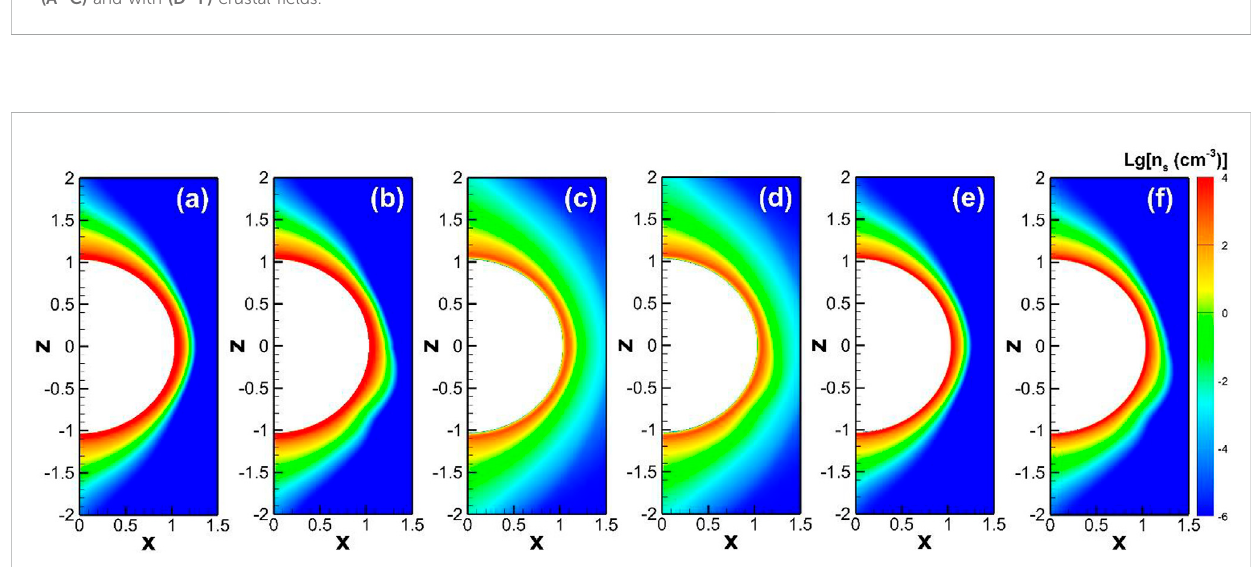
FIGURE 5 The dayside distributions of the logarithmic number density of O 2 + (A, B) , O + (C, D) , and CO 2 + (e. f) in the x-z plane, in the case without (A, C, E) and with (B, D, F) crustal fi